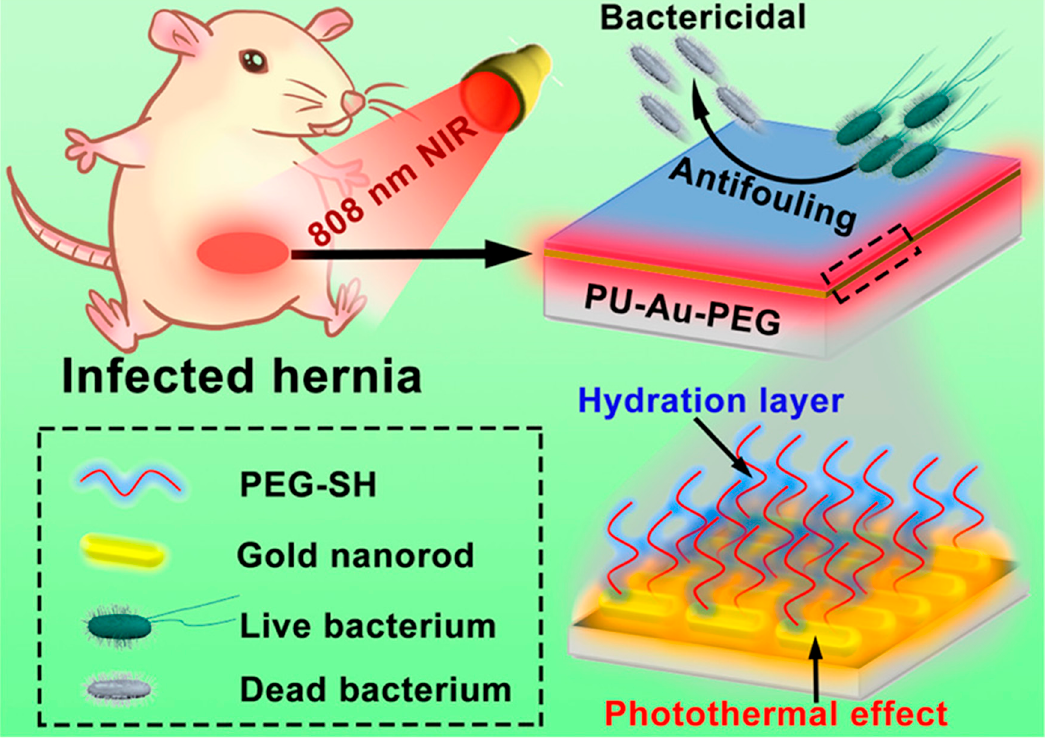
Figure 12. Antibacterial activity of polymeric gold nanorods due to a photothermal effect. Reproduced from [96], with permission from American Chemical Society, 2020.